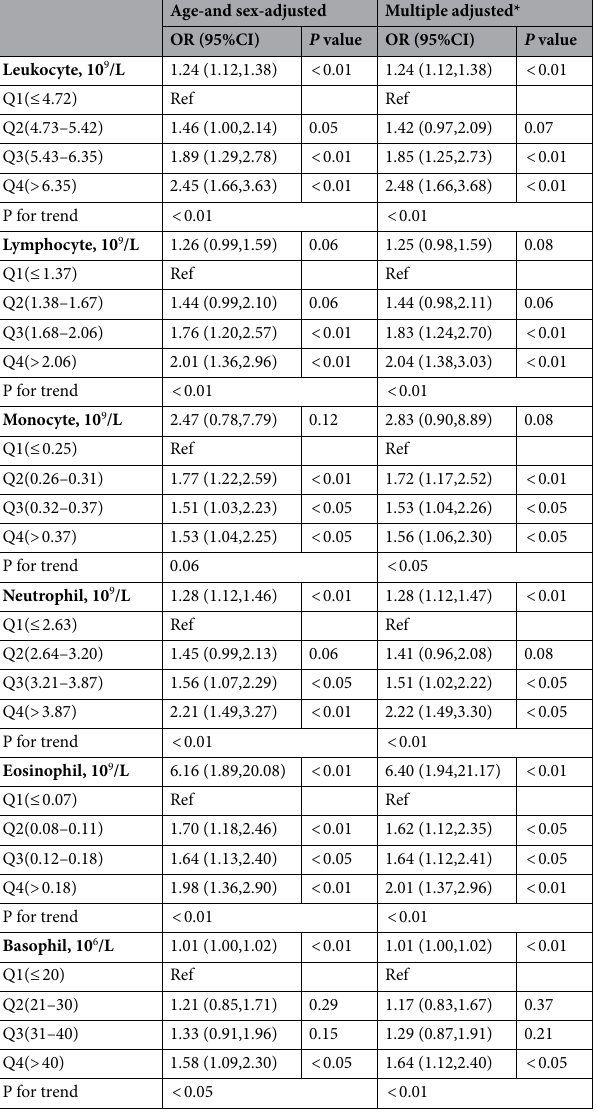
Table 3. Adjusted Relationships of Leukocyte-related Parameters to the Prevalence of MUO. *Adjusted for age, sex, smoking, tea consumption, alcohol consumption, and education